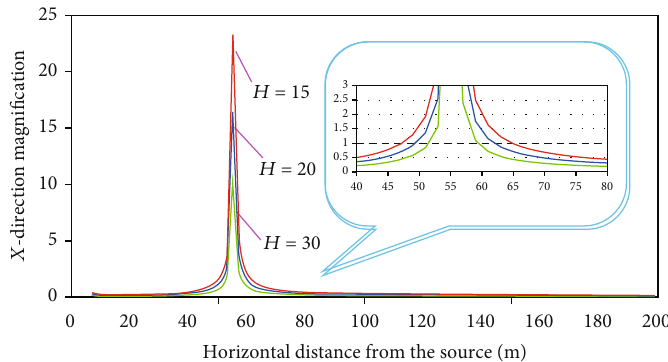
Figure 3: X -direction particle vibration speed magni fi cation.